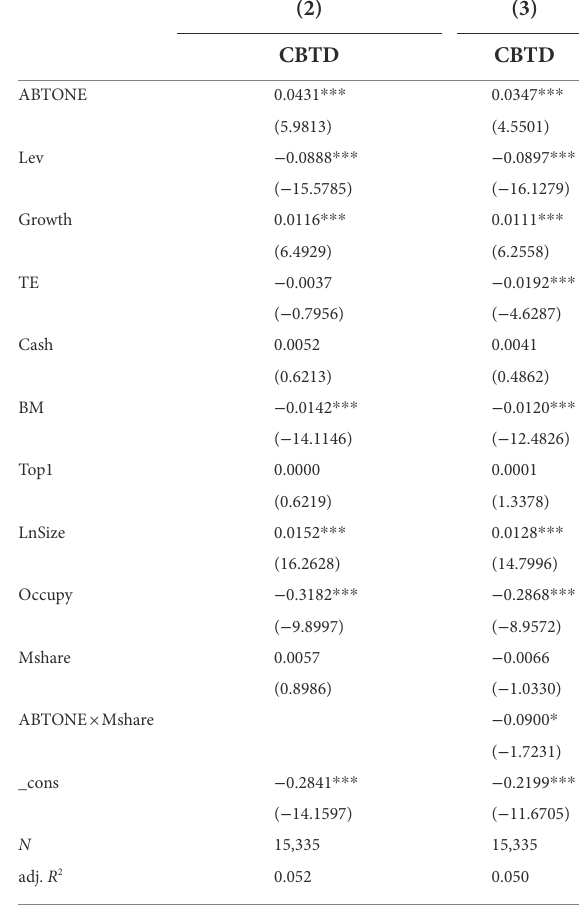
TABLE 4 Moderating effect of the managers’ stockholding